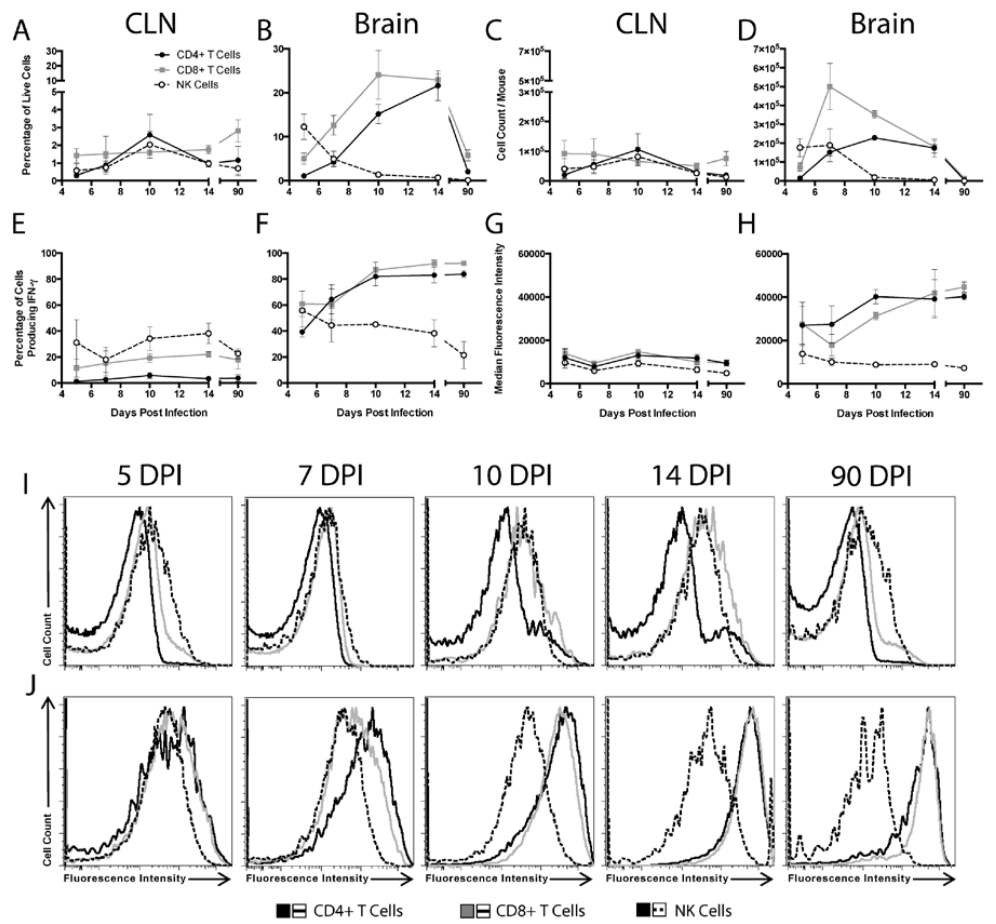
Figure 3. Source of IFN- γ during SINV infection. Flow cytometry was used to evaluate what cells were producing IFN- γ in the CLNs ( A , C , E , G , I ) and brains ( B , D , F , H , J ) of WT mice at 5, 7, 10, 14 and 90 DPI. CD4 + T cells (black circle and solid line), CD8 + T cells (gray square and solid line), and NK cells (white circle and black dashed line) producing IFN- γ were examined as both the percentage of live cells ( A , B ) and absolute cell counts ( C , D ). Also evaluated were the percentage of each cell type producing IFN- γ ( E, F) and the MFI of IFN- γ for each cell type presented in graph form ( G , H ) and as histograms ( I , J ) ( n = 3–7 pooled mice per time point from three independent experiments, except for data from 5 DPI CLNs, which were from two independent experiments; data are presented as the mean ± SEM).